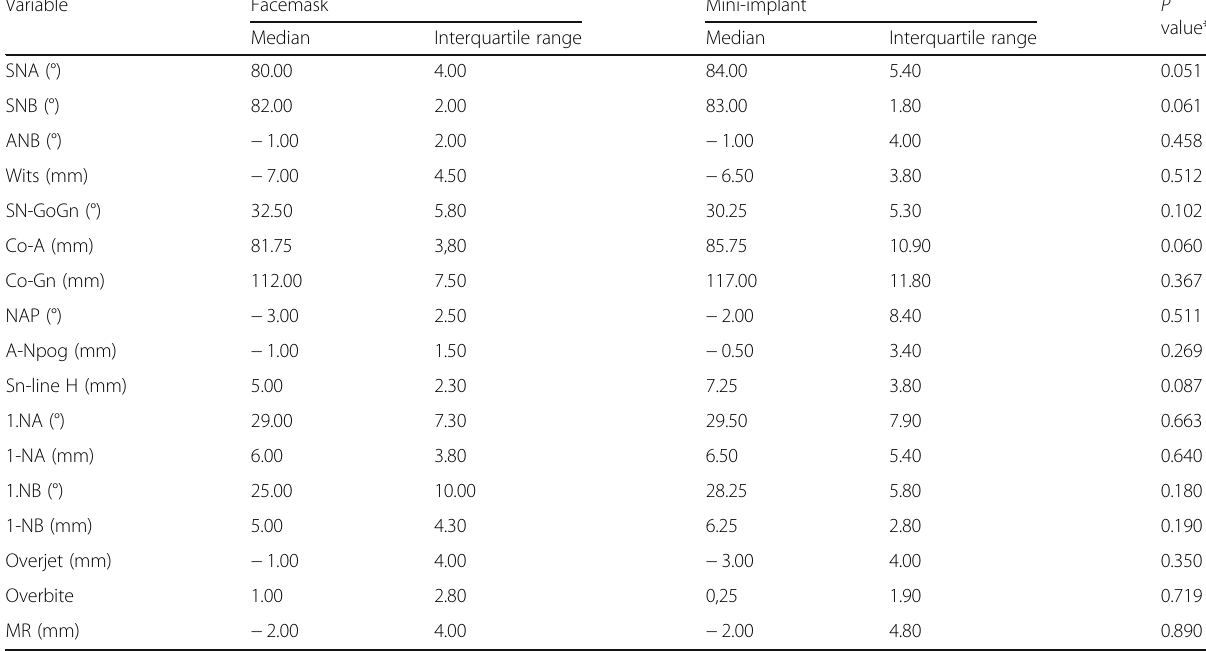
Table 1 Intergroup comparisons of initial facial characteristics (T0) of the sample Variable